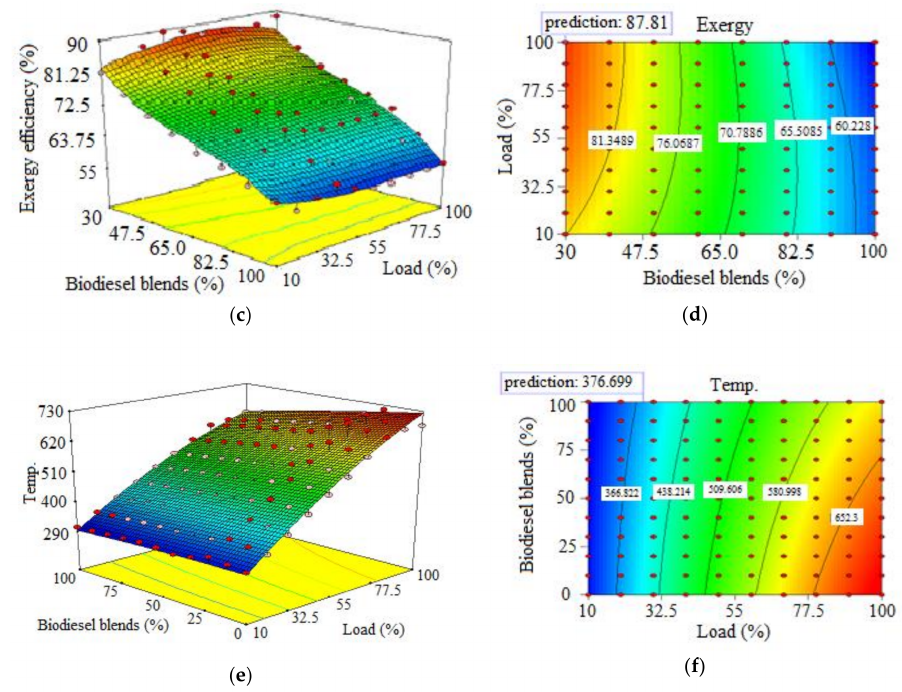
Figure 8. The optimum conditions for operating the engine based on energy and exergy efficiency for ANN-RSM method. ( a ) Energy efficiency; ( b ) contours of Energy efficiency; ( c ) Exergy efficiency; ( d ) contours of Exergy efficiency; ( e ) Temperature; ( f ) contours of